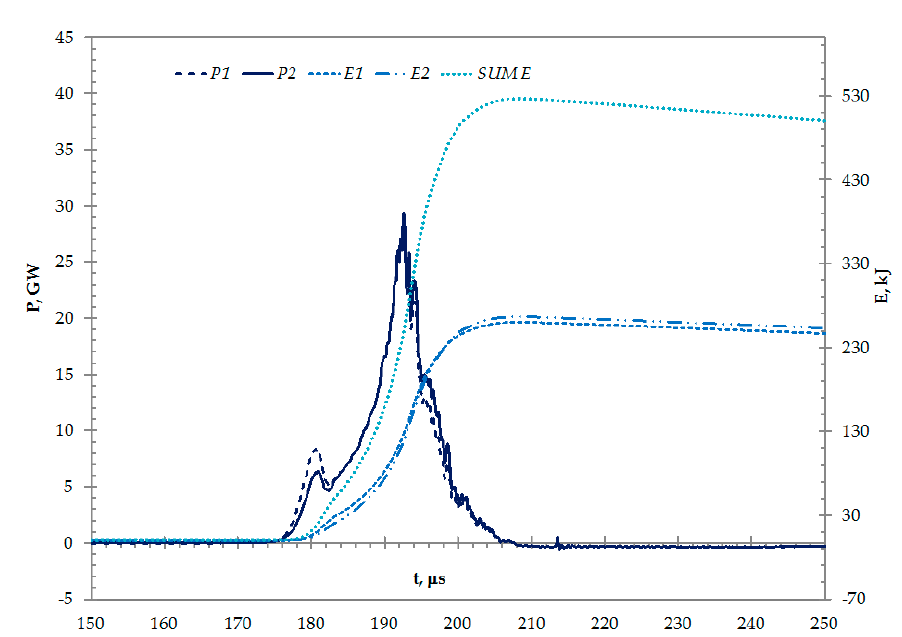
Figure 10. Power and energy inputted for each branch of the load.